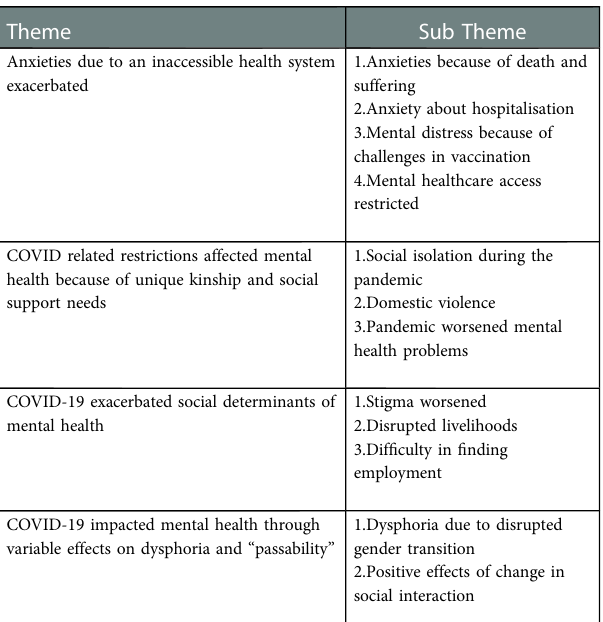
TABLE 1 Summary of the thematic